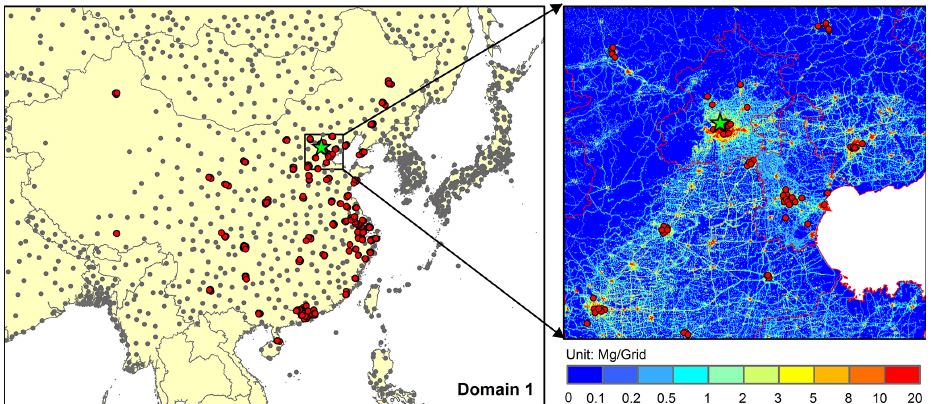
Figure 2. Simulation domain (Domain 1) and the monitoring stations. Gray circles are meteorological stations included in the NCDC data set and red circles are monitoring stations included in the CNEMC data set. Green star is the monitoring station at THU. Background in the enlarged map is NO x emission inventory of January 2013 at a horizontal resolution of 1km. Table 3. Domain, configurations and options used in CMAQ